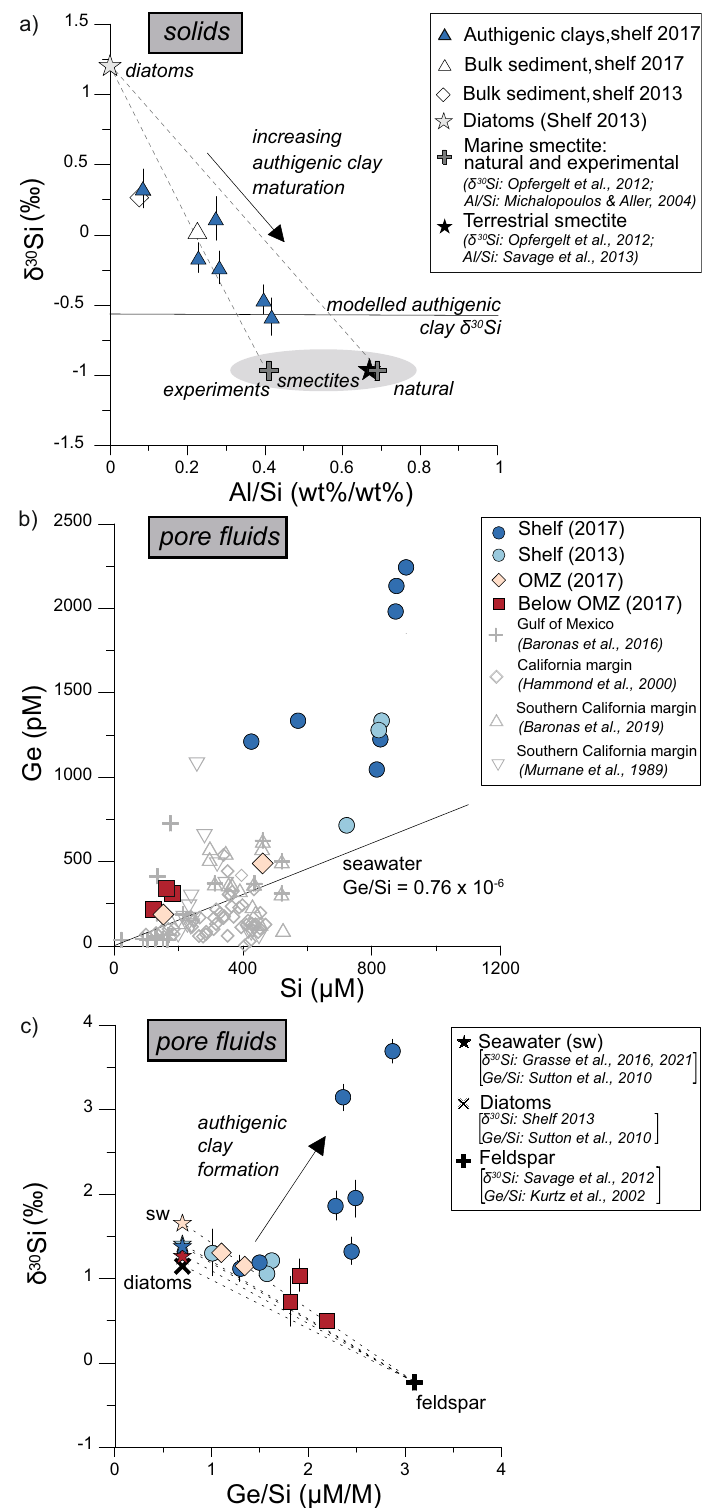
Fig. 4 | Silicon isotope and geochemical trends in solids and pore fl uids. a In- situ δ 30 Si of authigenic clays and bulk sediment of the Peruvian shelf in 2017 and bulk sediment analyses from the shelf in 2013. Error bars are 2SD of individual measurements. Horizontal line is the average modeled authigenic clay δ 30 Si sig- nature following the coastal El Niño (see also Table S10, Fig. S4). Note that the ‘ diatom ’ endmember,whichupondissolution,determinesthepore fl uid δ 30 Sifrom which the authigenic clays precipitate. The trend to lower authigenic clay δ 30 Si is likely due to increasing maturation of an amorphous gel-like precursor phase to